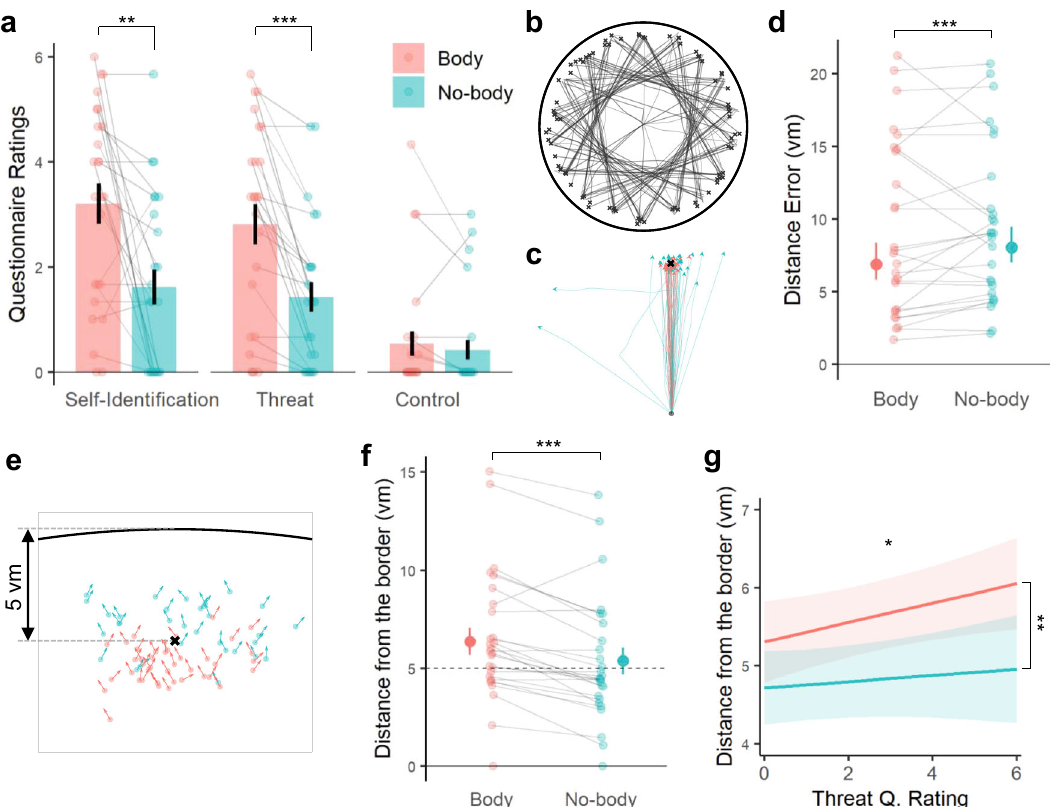
Fig. 2 Enhanced self-identi fi cation was improved spatial navigation performance in the Body condition. a Ratings of the questionnaire con fi rmed the effect of the experimental modulation on BSC ( n = 25). Self-identi fi cation (Q1: p = 2.53e-03) and experienced threat (Q2: p = 1.42e-04) were rated signi fi cantly higher in the Body vs. the No-body condition. Each bar represents the condition-wise mean across participants, while each error bar indicates a standard error. b Exemplary traces from a participant during the spatial navigation task. c Overlay of the navigation traces per condition during the retrieval phase of the same participant (traces were rotated and shifted according to the starting and the target location, in order to better visualize the difference in distance errors and navigation ef fi ciency). d Participants showed better spatial memory precision, indexed by lower distance errors from the correct retrieval targets ( n = 27; p = 8.25e-04). In the graph, a point with whiskers indicates distance error and its 95% con fi dence interval estimated by the mixed-effect model. Each smaller dot represents the median of an individual participant per condition. e The arrows display the trial-by-trial reached locations and heading directions of an exemplary participant. Locations are plotted relative to the correct target point ( “ x ” ), and the arena ’ s border (black bold line). f Participants stopped farther away from the arena ’ s border compared to the No-body condition during which no virtual avatar was presented ( n = 27; p = 4.80e-13). A point with whiskers indicates distance error and its 95% con fi dence interval estimated by the mixed-effect model. Each smaller dot represents the median of an individual participant per condition. g Mixed-effect model slopes relating Threat (Q2) to the distance from the border in the two conditions ( n = 25; p = 0.026 without correction), while taking into account the condition-wise difference ( p = 9.67e-3). For the pannels d , f participant-wise median values were visualized, while the statistical analysis was performed with the trial-wise values through a dedicated mixed model. *0.01 < = p < 0.05, **0.001 < = p < 0.01, *** p <